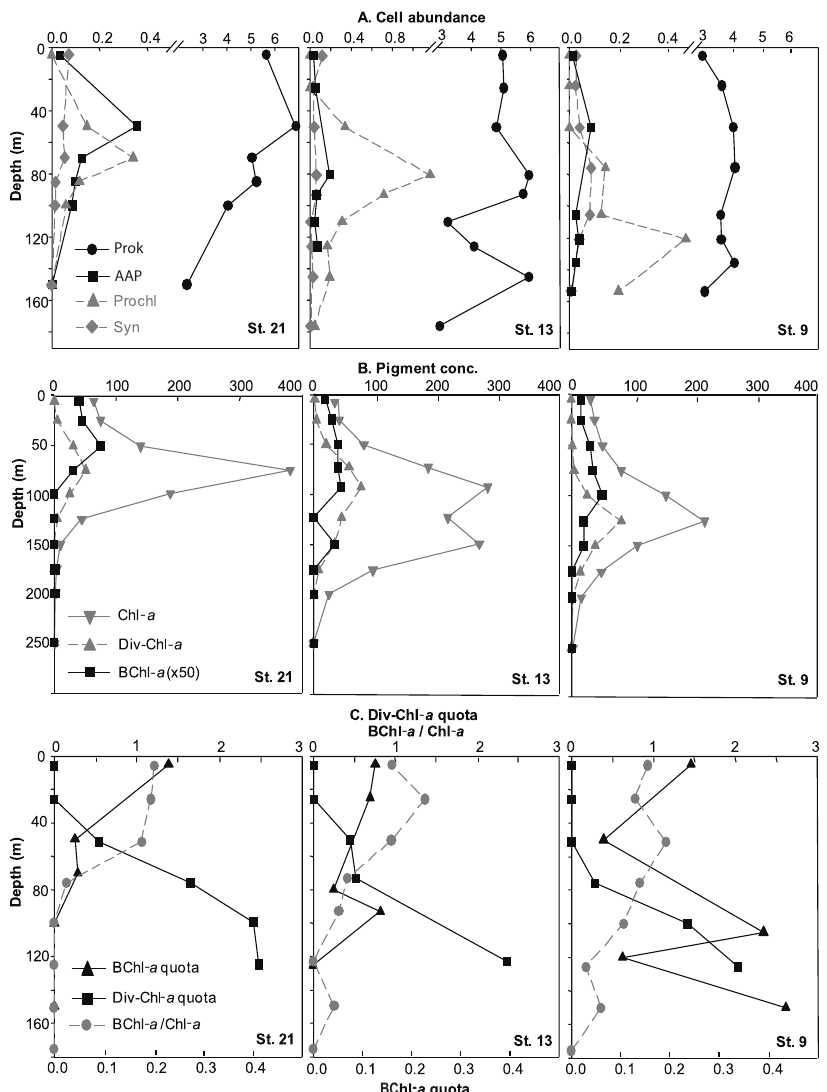
Fig. 4. Vertical profiles at stations 21, 13 and 9 of (A) total prokaryotes, AAP bacteria, Prochlorococcus and Synechococcus abundances (10 5 cellsml − 1 ) , (B) Chl- a , Div-Chl- a and BChl- a concentrations (ngl − 1 ) and (C) Div-Chl- a and BChl- a content per cell (fgcell − 1 ) and BChl- a /Chl- a ratios